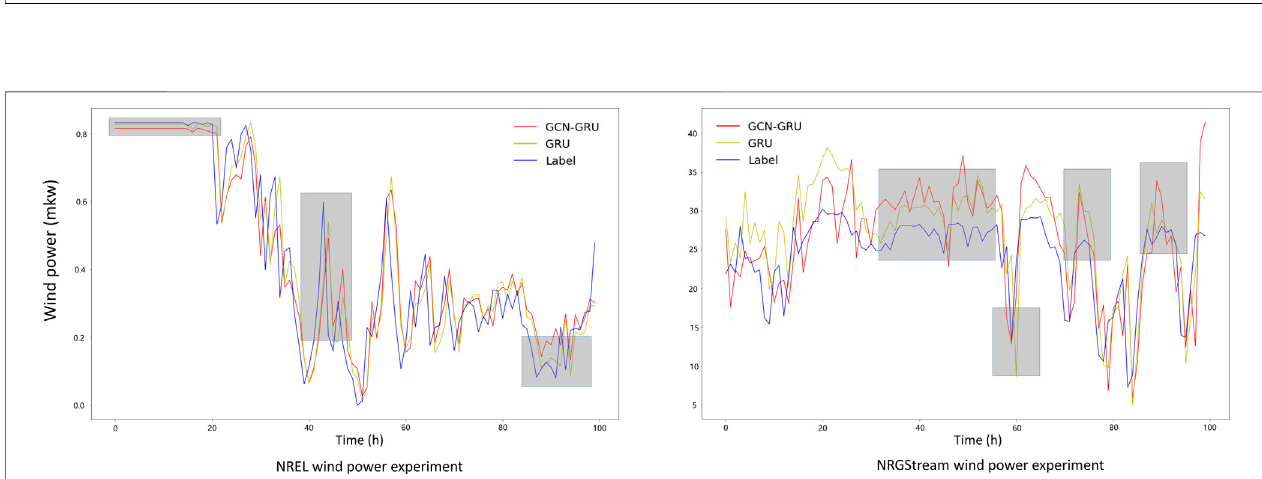
FIGURE5| ComparisonoftwowindpowerpredictionexperimentsbetweenGCN-GRUandGRU;thegrayareasarewhereGRU ’ spredictioncurvesclosertoreal curve, namely, GRU performs better than GCN-GRU in one-step wind power prediction.